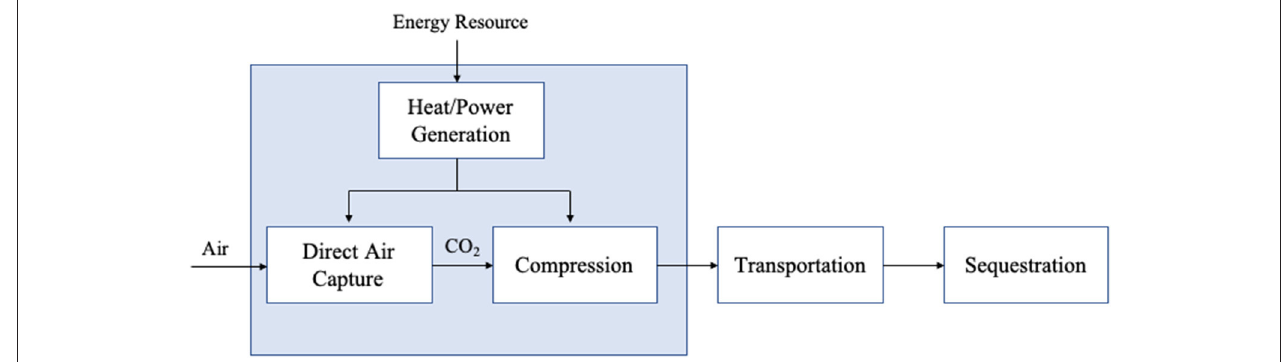
FIGURE 1 | Boundary conditions for this analysis (blue box) where DAC is coupled to a dedicated energy resource to maximize CO 2 removal impact. Additional unit operations outside the blue box represent further processing outside the scope of this analysis.